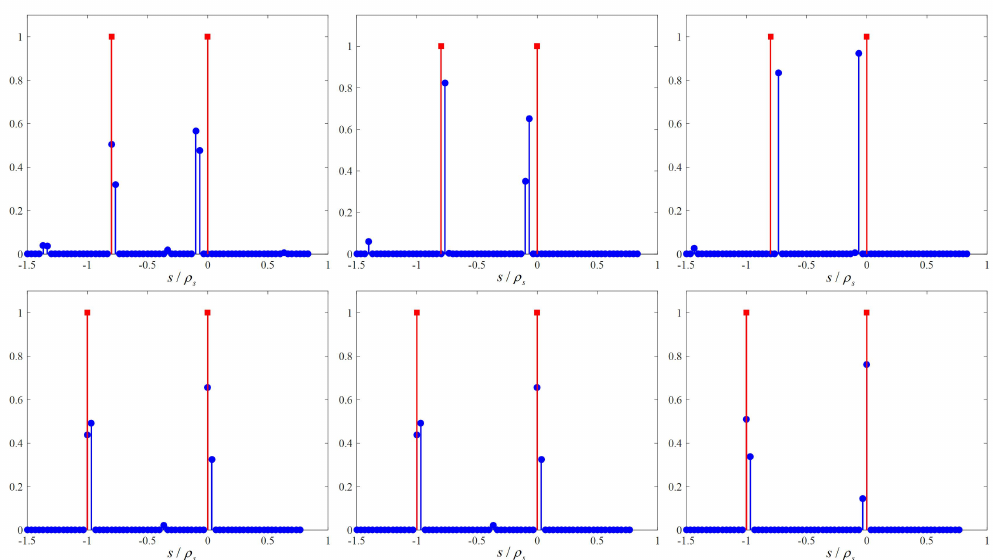
Figure A1. Profile reconstruction by CS under different λ . From left to right, λ = 1 respectively. All figures are with two scatterers with the same magnitude a s but with different separations ( ∆ s = ρ s for the top figures and ∆ s = 0.8 ρ s for the bottom figures). The red squares are the true locations, while the blue dots are the estimated ones. Please note that the x -axis and the y -axis are normalized to ρ s and a s ,